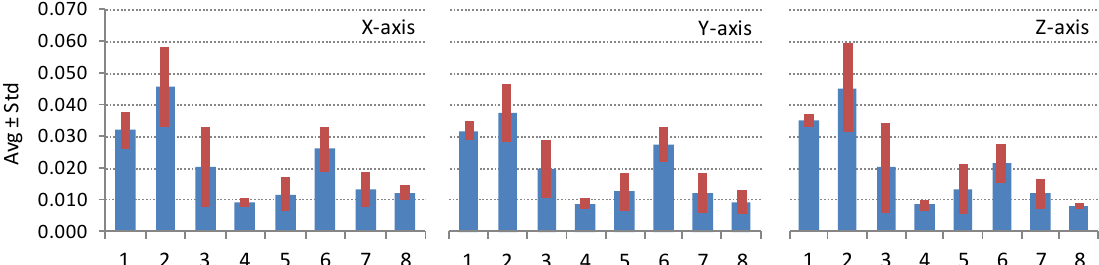
Figure 6. Comparison of average gyroscope noise parameter ARW and its standard deviation for eight different smartphone models. Smartphone models presented are the same as in Figure 5. The vertical axis shows ARW in [deg/s/ Hz